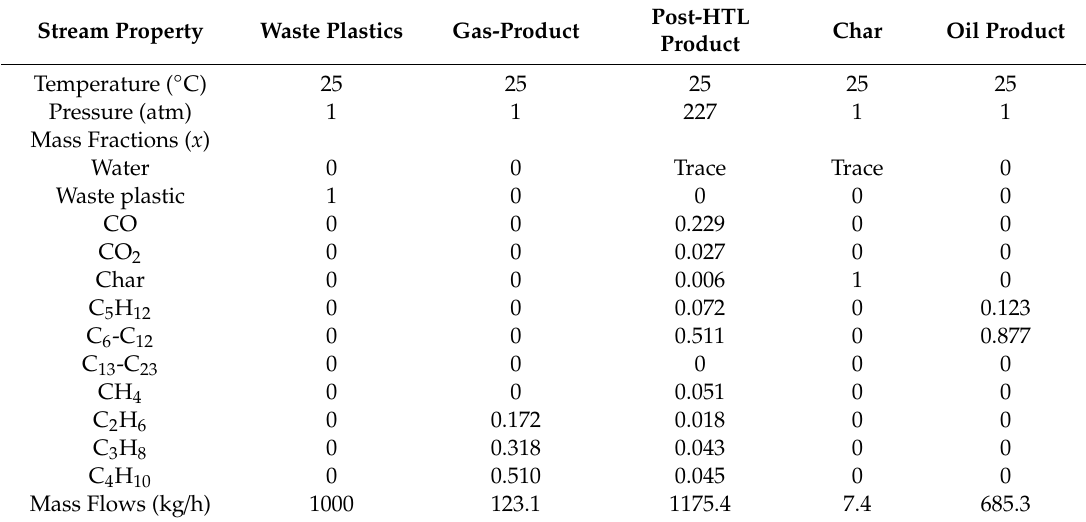
Table 3. Mass balance results for major streams in scenario